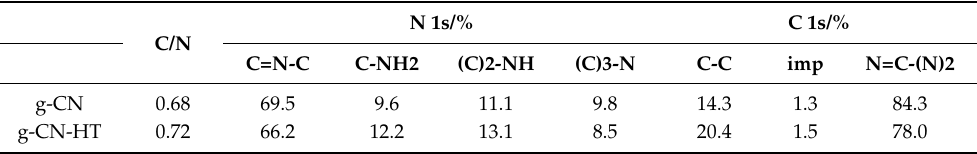
Table 1. Surface chemistry determined as% from the XPS core-level spectra of N 1s and C